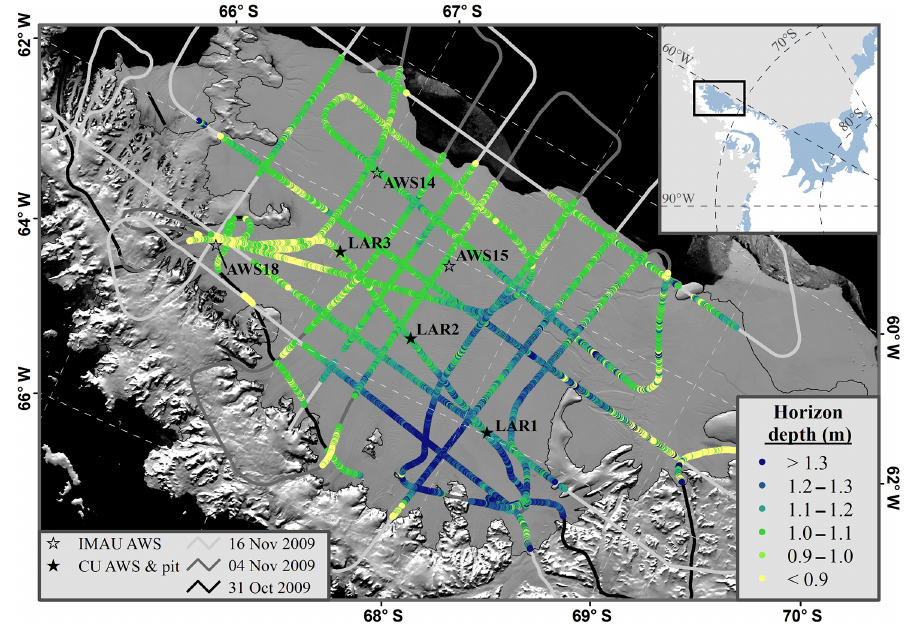
Figure 8. Map of the LCIS showing Operation IceBridge reflector depths (in metres) for the 2009 flight lines. Stars indicate the locations of automatic weather stations, with solid stars at locations where snow pit observations were made concurrent with the OIB overpasses. Table 3. Comparison of reflector depths from OIB radar data with snow height changes for the corresponding period. End-of-melt date is estimated from space-borne scatterometry (Trusel et al., 2013); distance denotes the minimum distance between the OIB flight track and the sonic height ranger